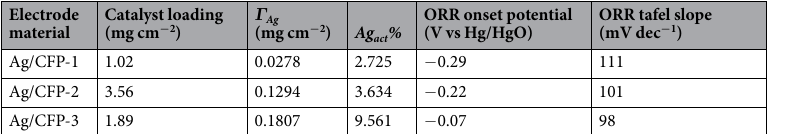
Table 1. Comparison of the electrode activity of the as-prepared